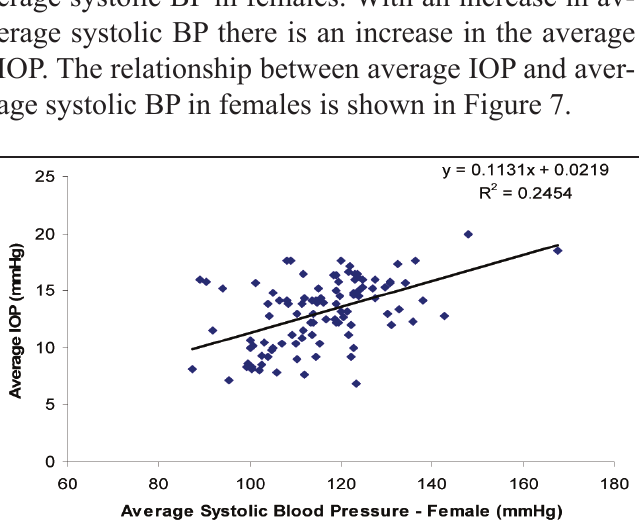
Figure 7: Relationship between average IOP and average systo- lic BP in